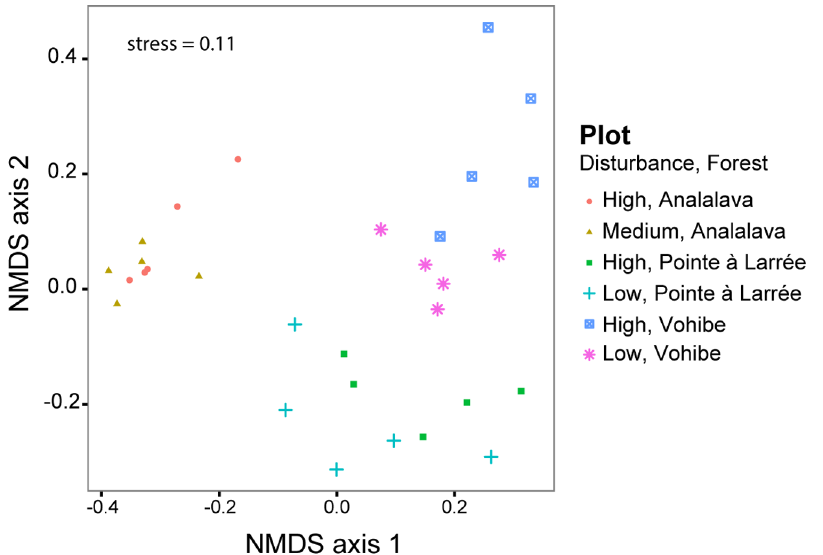
Figure 4. Nonmetric multidimensional scaling (NMDS) plot of pairwise Bray-Curtis dissimilarities between bacterial communities in soil calculated with 3%